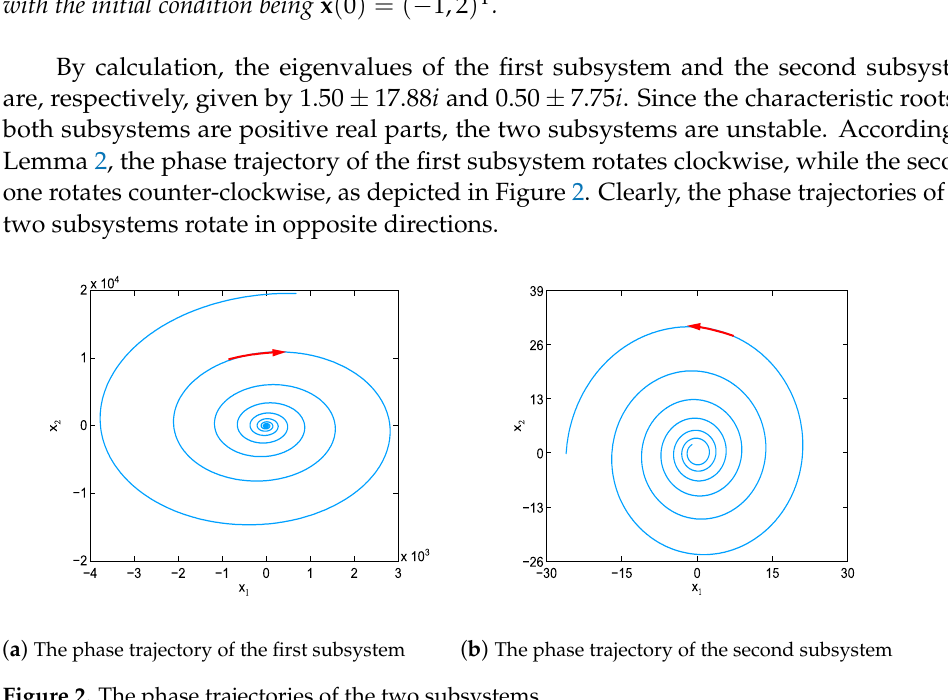
Figure 2. The phase trajectories of the two